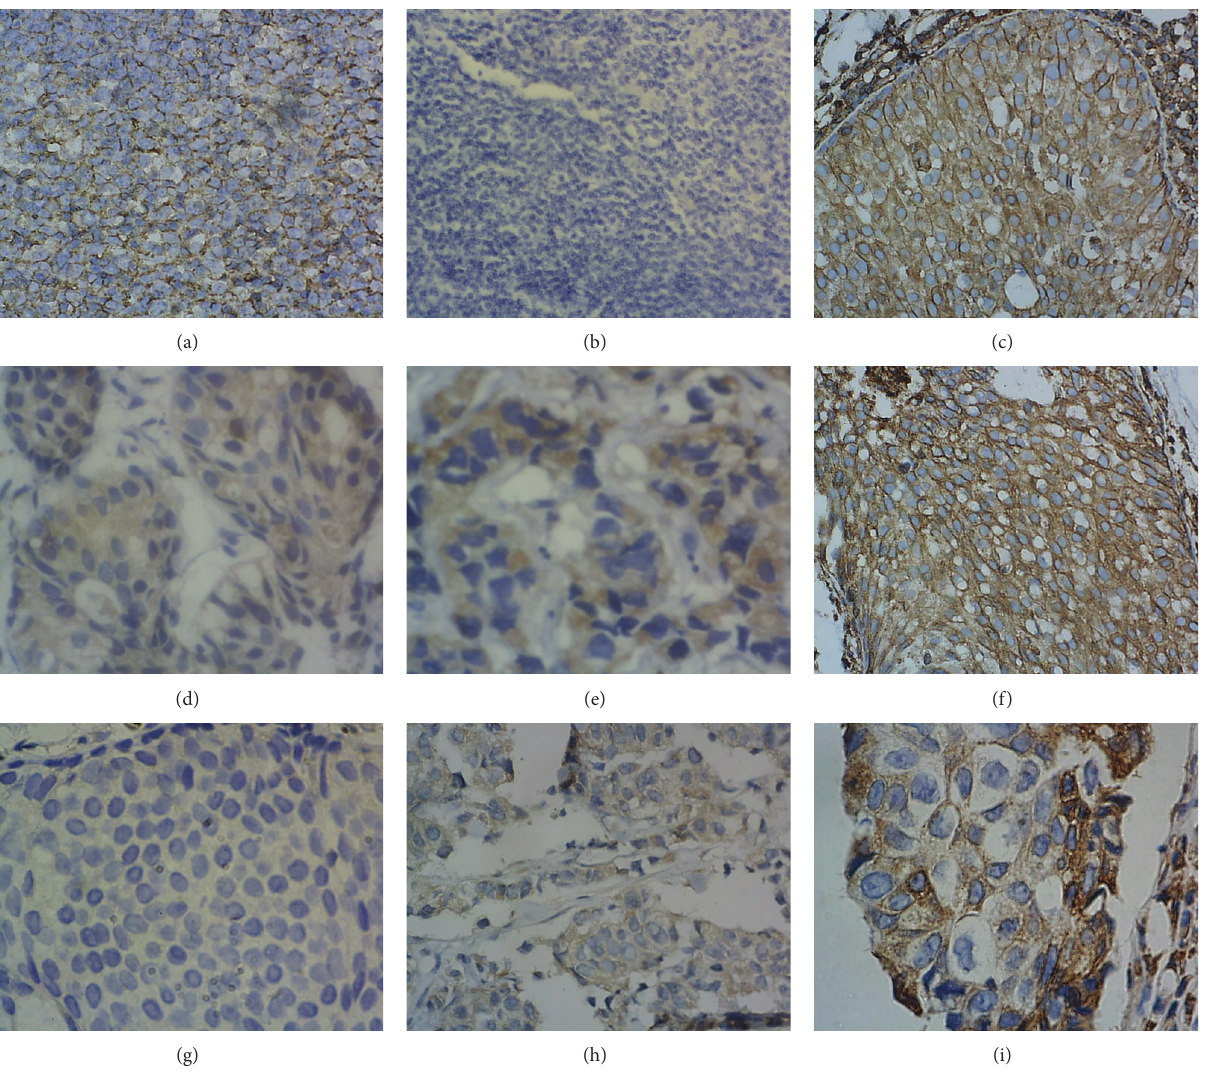
Figure 1: Immunoperoxidase labeling of HLA-Ia, HLA-II, HLA-G, and HLA-E in cytoplasmatic membranes of IDC breast tumor cells and controls. (a) Positive control for HLA-I, HLA-DR, and HLA-DQ expression in human tonsil slides, showing immunolabeling in > 10%. (b) Negative control, human tonsil slides without primary antibodies, showing absence of immunolabeling. (c) HLA-I expression in IDC classified as positive, showing brown immunolabeling in > 10%. (d) HLA-DQ expression in IDC classified as positive, showing intense brown immunolabeling in > 10%. (e) HLA-DR expression in IDC classified as positive, showing intense brown immunolabeling in > 10%. (f) Positive control for HLA-G and HLA-E expression in human trophoblast slide, showing immunolabeling in > 25%. (g) Negative control, human trophoblast slide without primary antibodies, showing absence of immunolabeling. (h) HLA-G expression in IDC classified as positive, presenting labeling in > 25%. (i) HLA-E expression in IDC classified as positive, showing labeling in > 25%. Bar scale 250 𝜇